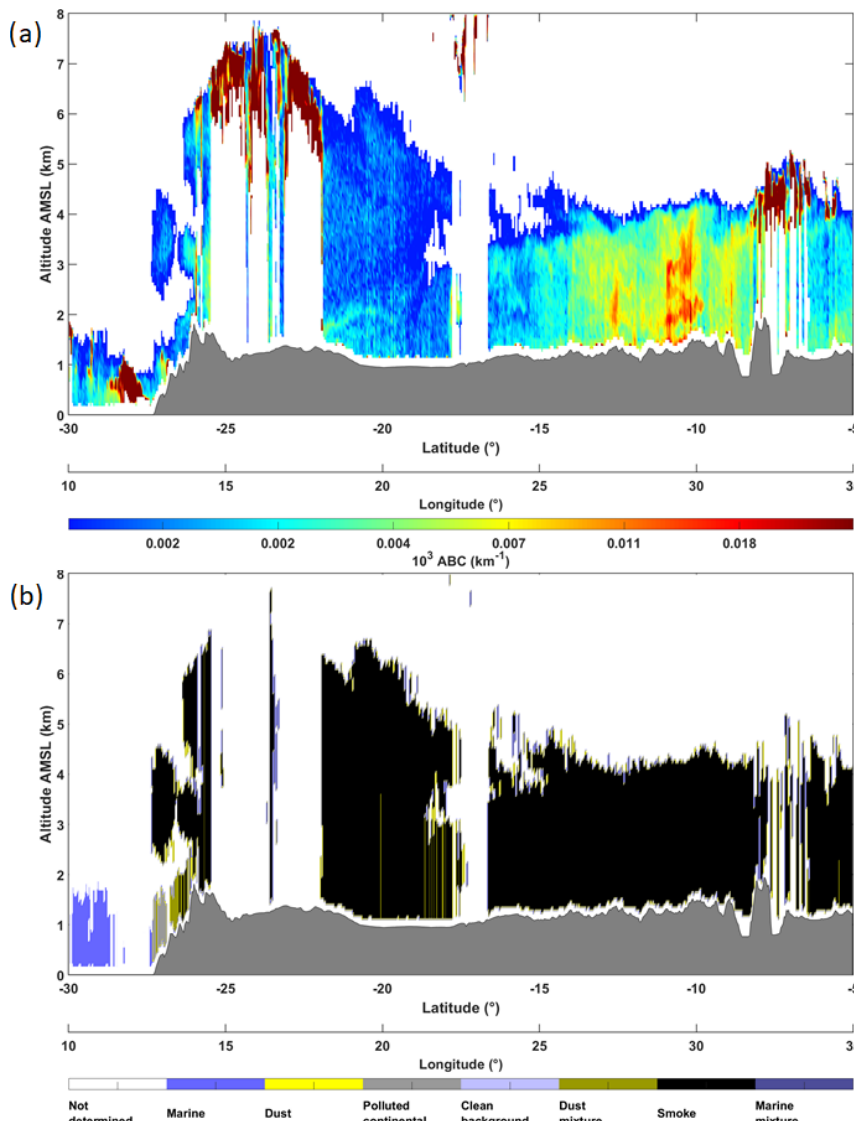
Figure 7. (a) Total attenuated backscatter coefficient from the space-borne lidar CATS between 22:05 and 22:21UTC on 5 September 2017. (b) Same as (a) but for CATS-derived aerosol. The corresponding CATS track is shown in Fig.